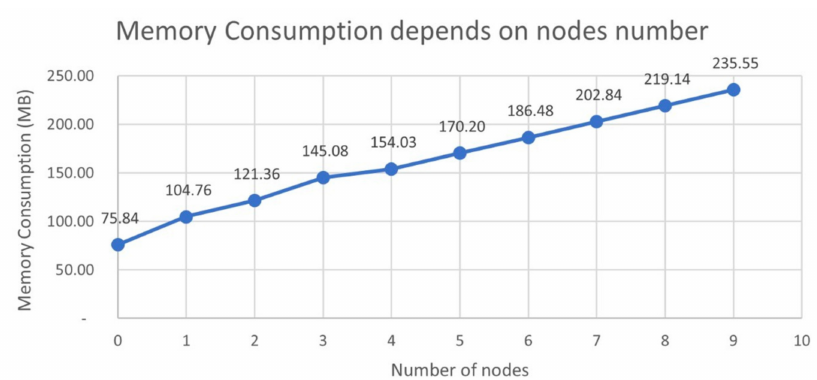
Figure 8. Memory consumption depends on nodes